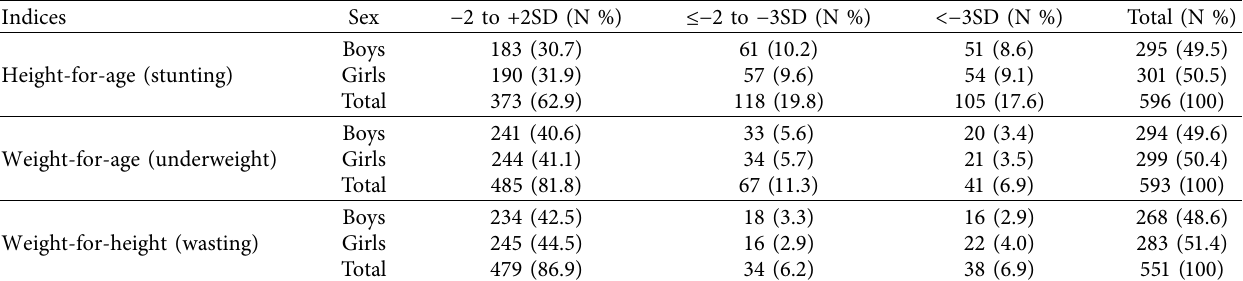
Table 2: Nutritional anthropometry: height-for-age, weight-for-age, and weight-for-height for children.